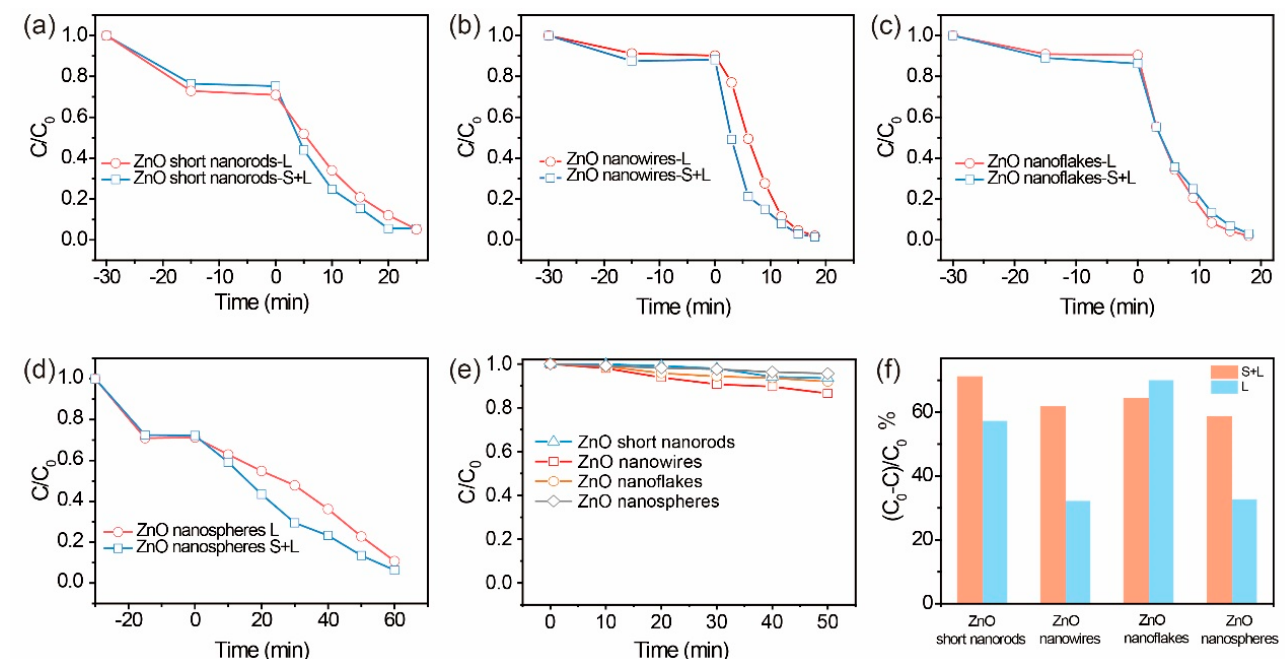
Figure 6. Photocatalytic degradation performance of ( a ) ZnO short nanorods, ( b ) ZnO nanowires, ( c ) ZnO nanoflakes, and ( d ) ZnO nanospheres. ( e ) Ultrasonic degradation curves for all the ZnO samples in dark. ( f ) Degradation enhancement of all samples compared at the points around 70% degradation under S+L condition (L: light illumination only, S+L: light illumination with ultra-sound).